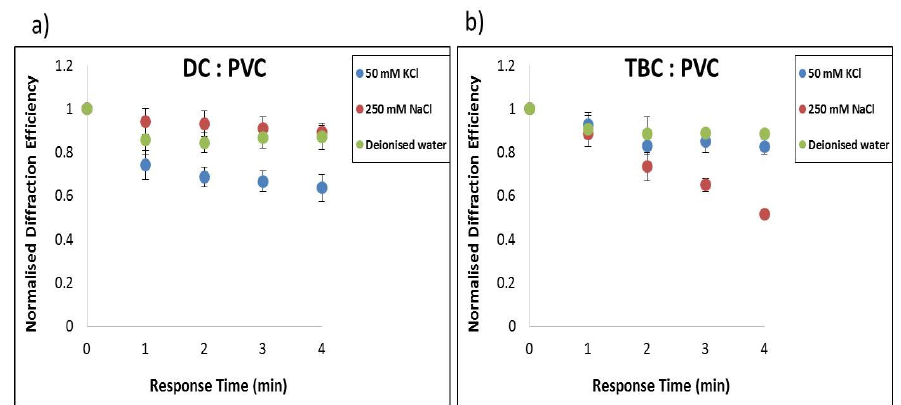
Figure 8. Comparison of relative response in terms of normalised DE change of ( a ) DC to 250 mM NaCl, 50 mM KCl and deionised water and ( b ) TBC coated structures to 50 mM KCl, 250 mM NaNO 3 , and deionised water.